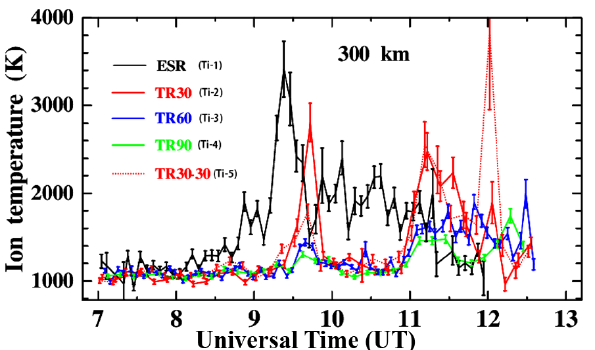
Figure 8. Electric field variations obtained from the EISCAT UHF radar ion drift observations at 282km altitude with beam 1, beam 2, and beam 4 on 12 March. The geographically northward and east- ward components are shown with blue and red lines,